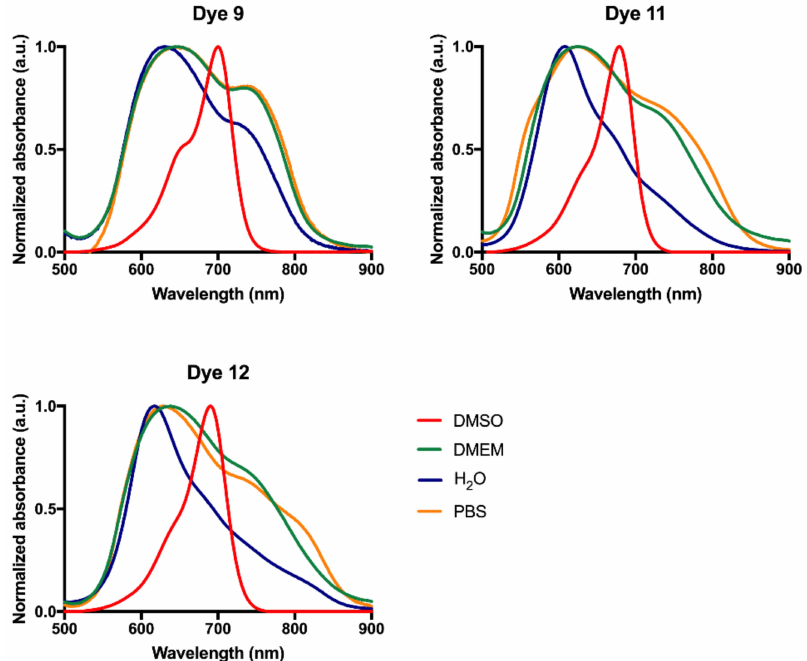
Figure 2. Normalized red and near-infrared absorption spectra of quinoline- and benzoselenazole- derived unsymmetrical squaraine cyanine dyes 9 , 11 and 12 acquired in dimethyl sulfoxide (DMSO), Dulbecco’s modified Eagle medium (DMEM), water and phosphate-bu ff ered saline (PBS) at room temperature. Absorption is presented as arbitrary units